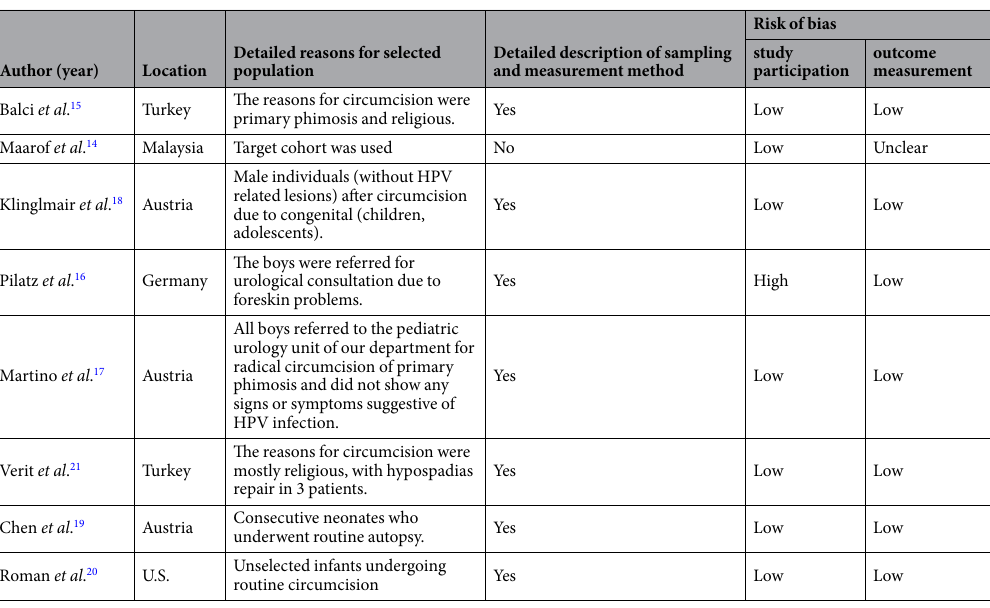
Table 2. Risk of bias for included